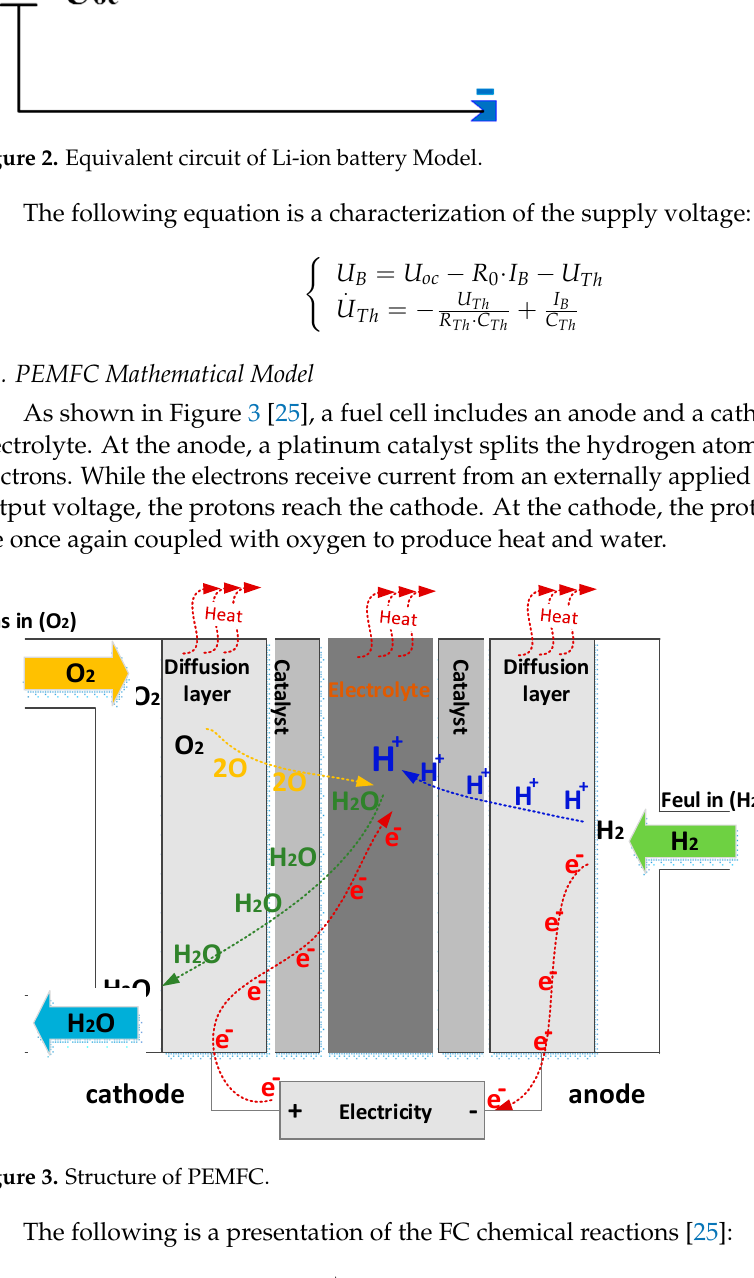
Figure 3. Structure of PEMFC.